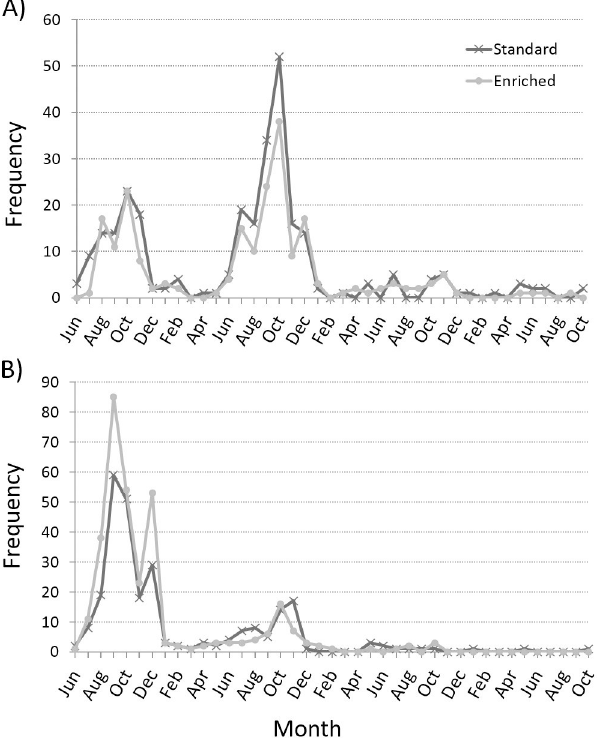
Fig 5. Number of tag recoveries per month for the enriched and standard salmon released into Lake Ho¨ytia¨inen at age A) 2 (June 2011–October 2014) and B) 3 (June 2012–October 2015). Tag recoveries per month for the enriched and standard salmon from Lake